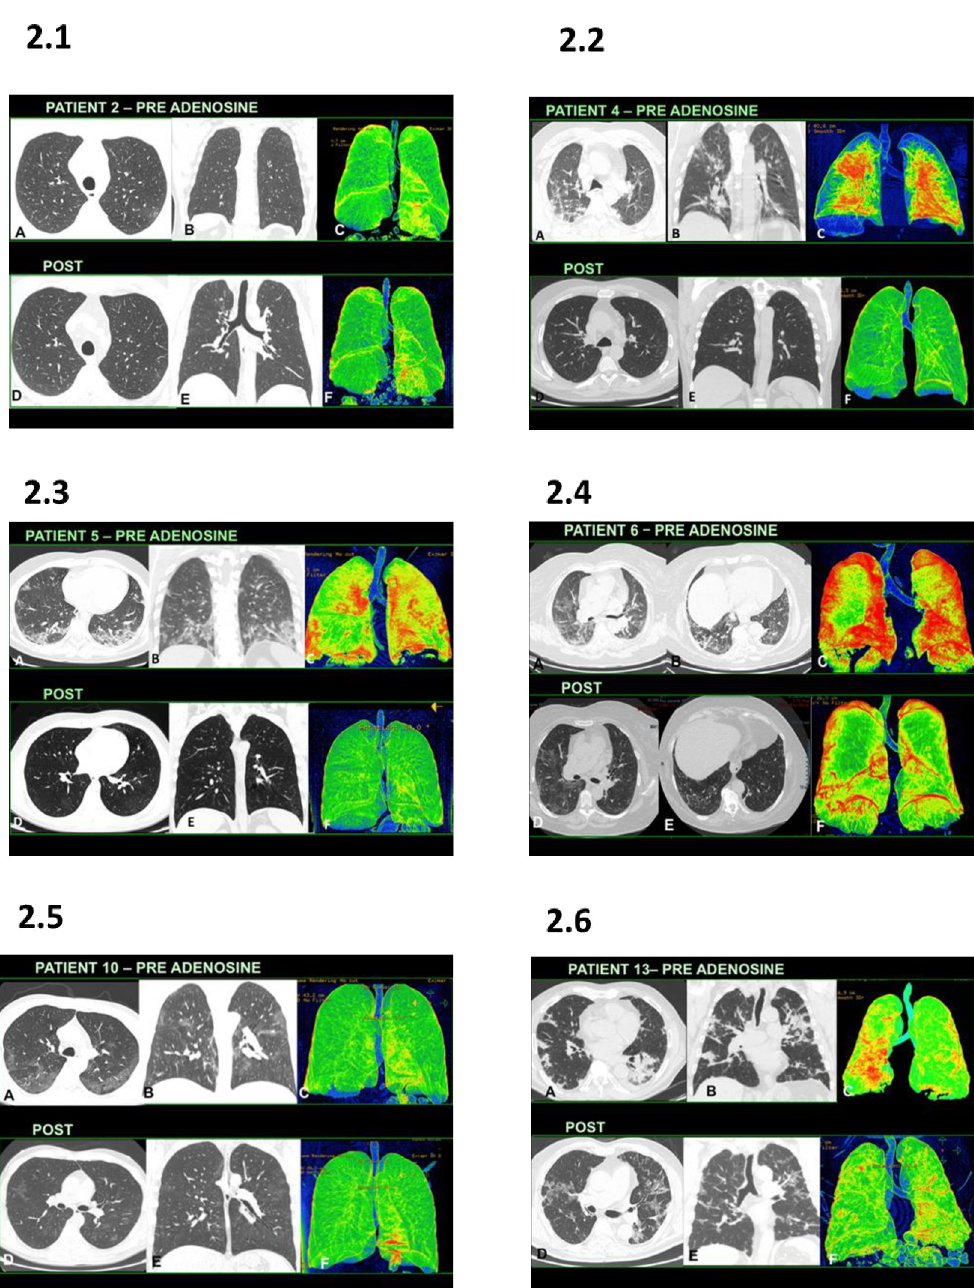
Fig 2. The High Resolution Computerized Scan (HRCT) monitoring before and after adenosine treatment. Panel. 2.1– Patient #2- (A-B) baseline HRCT shows signs of interstitial pneumonitis with focal area of ground-glass in the RSL; (C) § Pre-treatment volume rendering. (D-E) Post-treatment HRCT shows widespread reduction in the interstitial pneumonitis. (F) § Post-treatment volume rendering. Panel 2.2 -Patient #4- (A-B) baseline HRCT shows signs of interstitial pneumonitis with areas of ground-glass in the RSL and LIL with pleura-parenchymal branches in the periphery; (C) § Pre-treatment Volume rendering. (D-E) Post-treatment HRCT shows wide-spread reduction in the interstitial engagement.(F) § Post- treatment volume rendering shows reduction in amorphous increase in lung density. Panel 2.3 -Patient #5- (A-B) baseline HRCT shows widespread signs of interstitial pneumonitis with areas of ground-glass and pleura-parenchymal branches, present in both lungs with spread to the periphery in the LIL and RIL.(C) § Pretreatment volume rendering. (D-E) post- treatment HRCT shows widespread reduction in the interstitial engagement. (F) § Post-treatment volume rendering shows a significant reduction in the parenchymal thickenings. Panel 2.4-Patient #6- (A-B) baseline HRCT shows widespread signs of interstitial pneumonitis with areas of groundglass and crazy paving, present in both lung fields with spreading to the